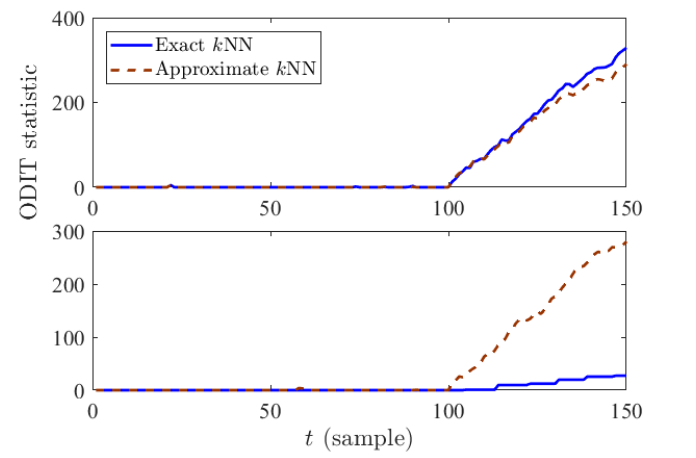
Figure 2. ODIT statistics based on exact and approximate k NN distances when T sampling = 1 s ( top ) and T sampling = 0.01 s ( bottom ).